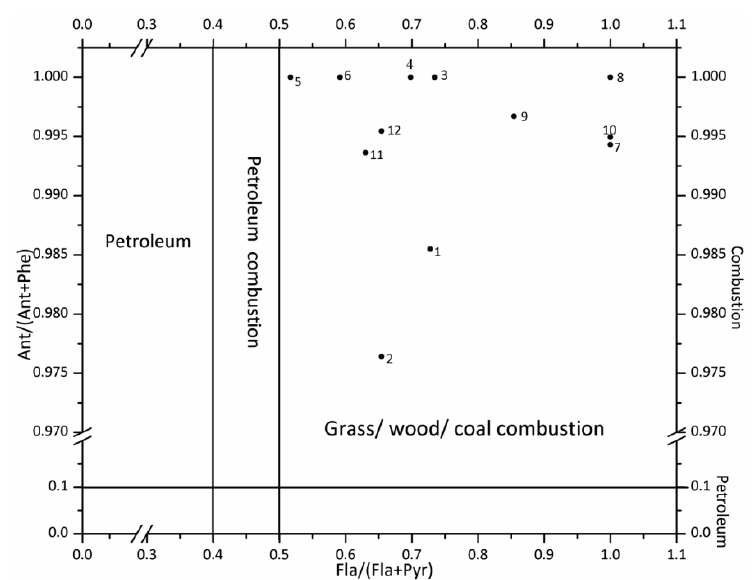
Figure 4. The cross-plots of 16 PAHs for the ratios of Ant/(Ant + Phe) vs. Flu/(Flu +